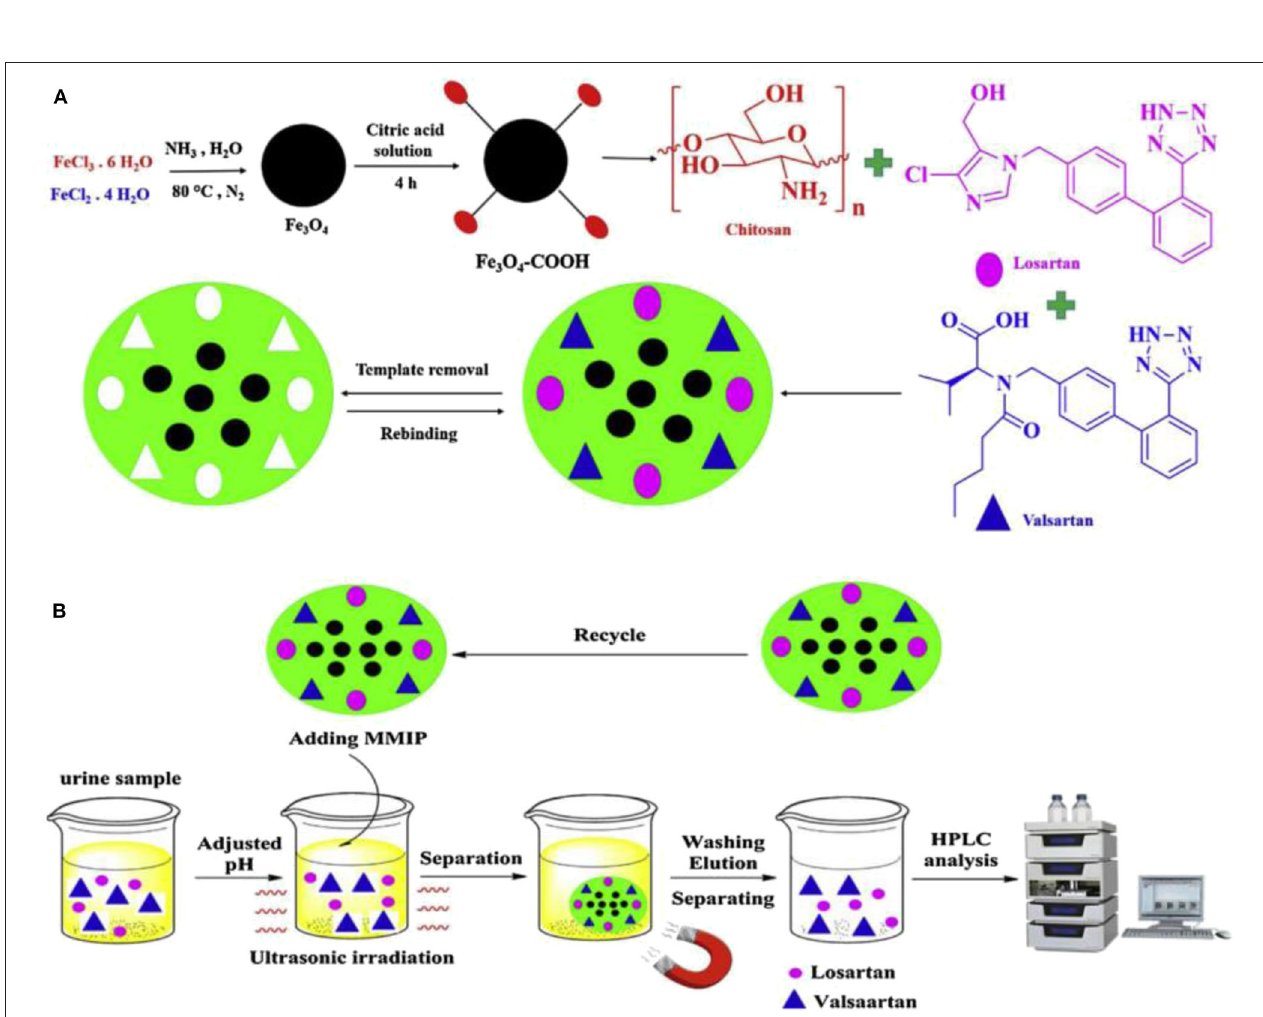
FIGURE 9 | The basic preparation procedure of MMIP (A) and the MMIP based MDSPE procedure for valsartan and losartan extraction (B) (Bagheri and Ghaedi, 2020). Reprinted with permission from Elsevier. Copyright (2020) Elsevier.